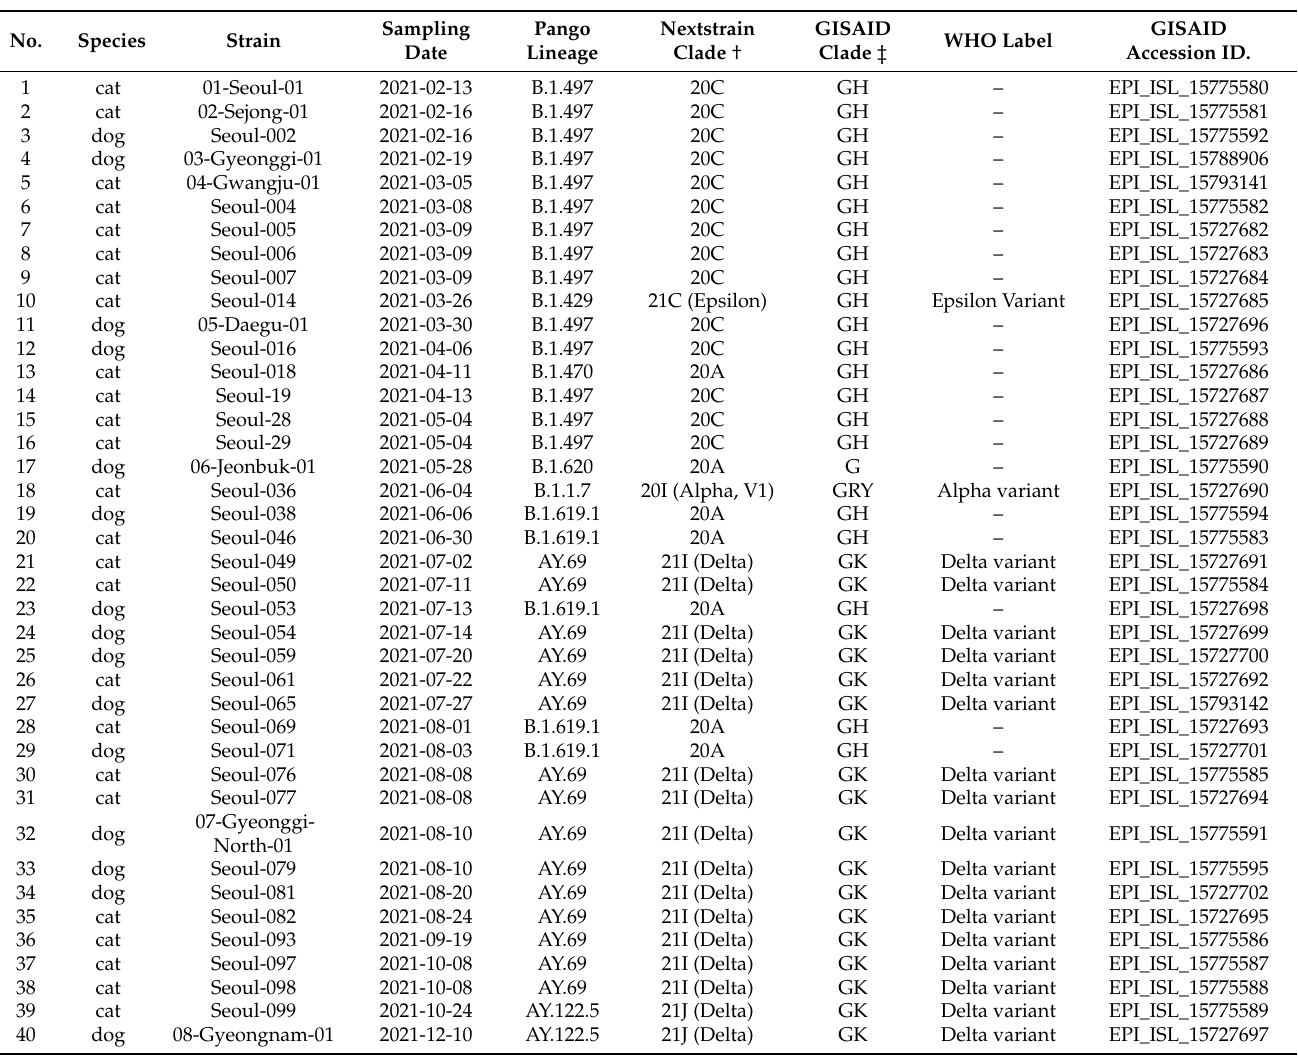
Table 2. Pangolin lineages of SARS-CoV-2 in 40 animal